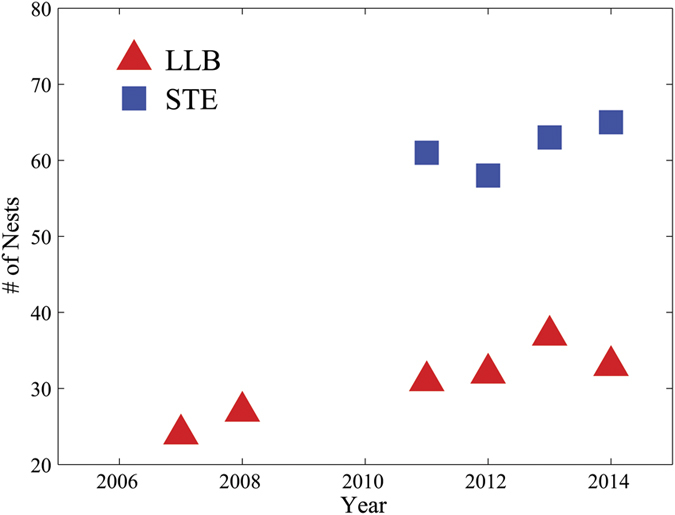
Number of nests located in the breeding area (215 km2) in the Judean Foothills, Israel.Note that long-legged buzzards (LLBs) and short-toed eagles (STEs) were not sampled during 2009–2010 and 2007–2010, respectively.